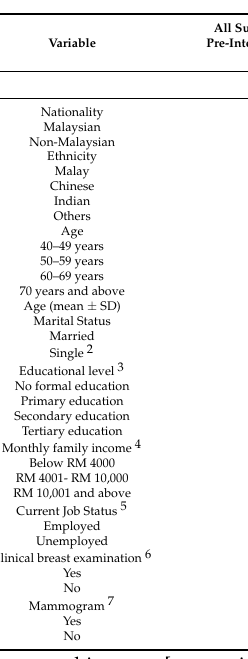
Table 1. Sociodemographic characteristics of